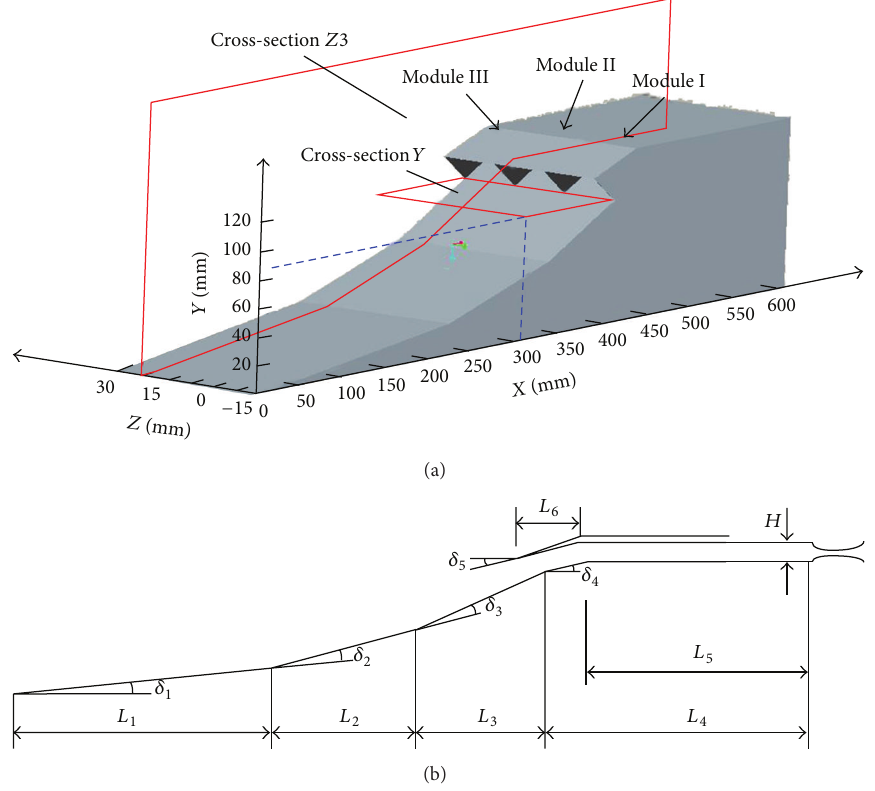
Figure 1: The 3D view of multiple-modules hypersonic inlet and geometric parameters.